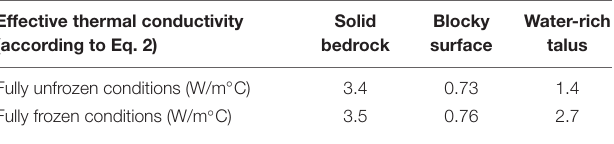
TABLE 2 | Effective thermal conductivities. Effective thermal conductivity (according to Eq.